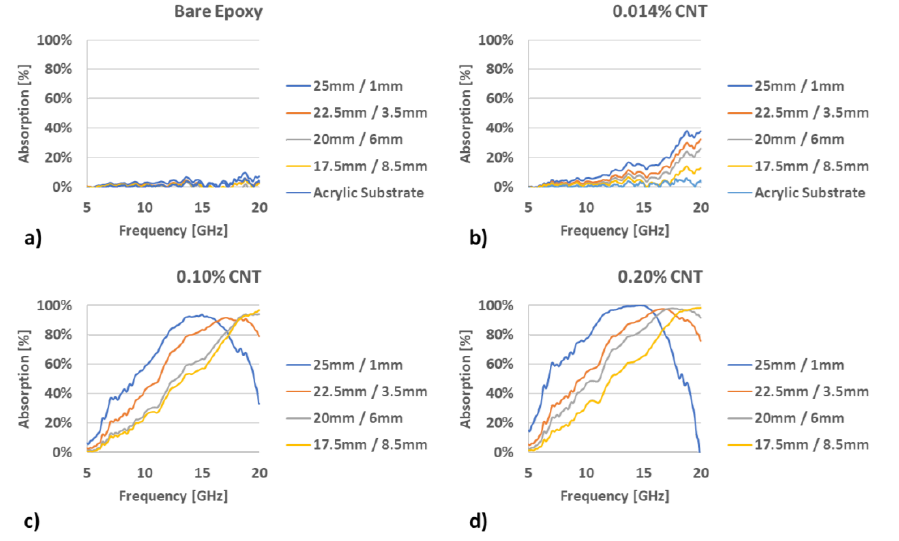
Figure 5. Percent absorption of CNT / epoxy composites at varying loadings: ( a ) 0%, ( b ) 0.014%, ( c ) 0.10%, and ( d ) 0.20%, respectively.